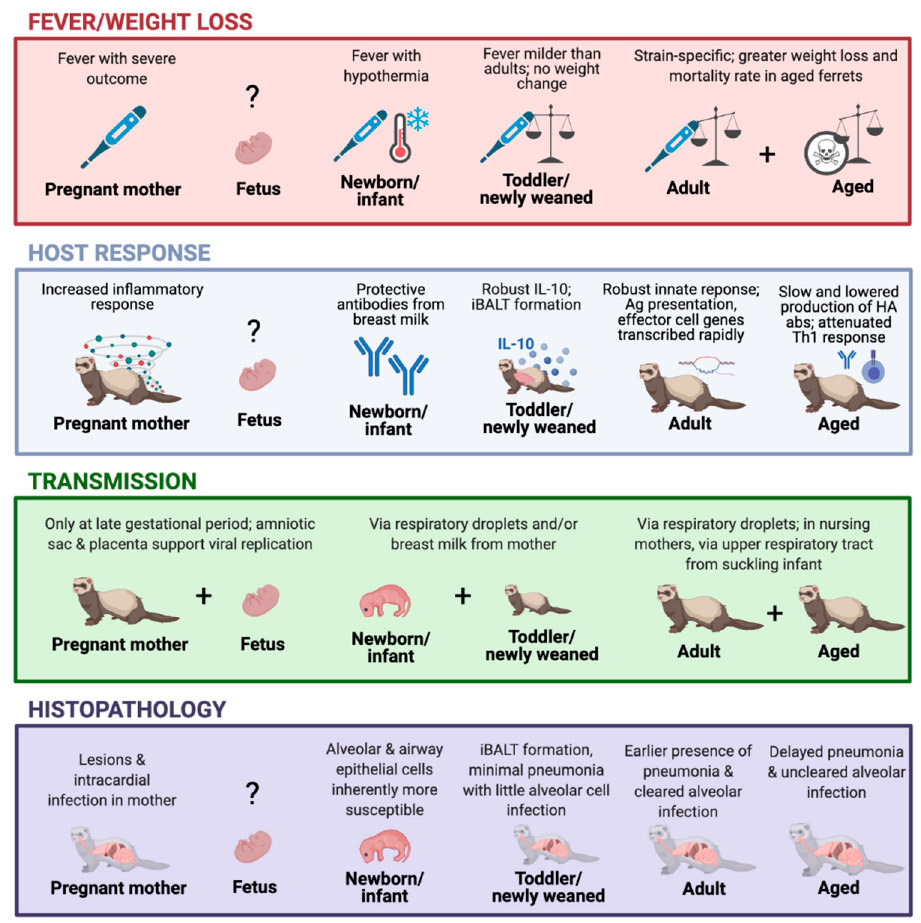
Figure 1. The ferret model timeline in response to influenza virus infection. The graph depicts the viral infection-induced illness, host response, transmission, and histopathology outcomes at differ- ent stages of the ferret lifespan, including pregnancy [24,29,75], fetus [29,31,76], newborn/infant [26–28,30,72–74], toddler/newly weaned [23,25], adults [24,50], and aged animals [25,77,78]. Cre- ated with BioRender.com.